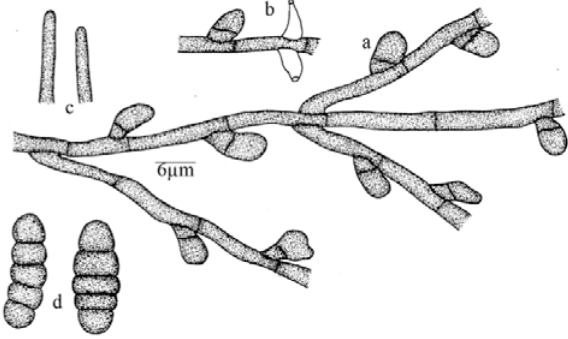
Figure 41. Meliola anceps a - Appressorium; b - Phialide; c - Apical portion of mycelial setae; d -